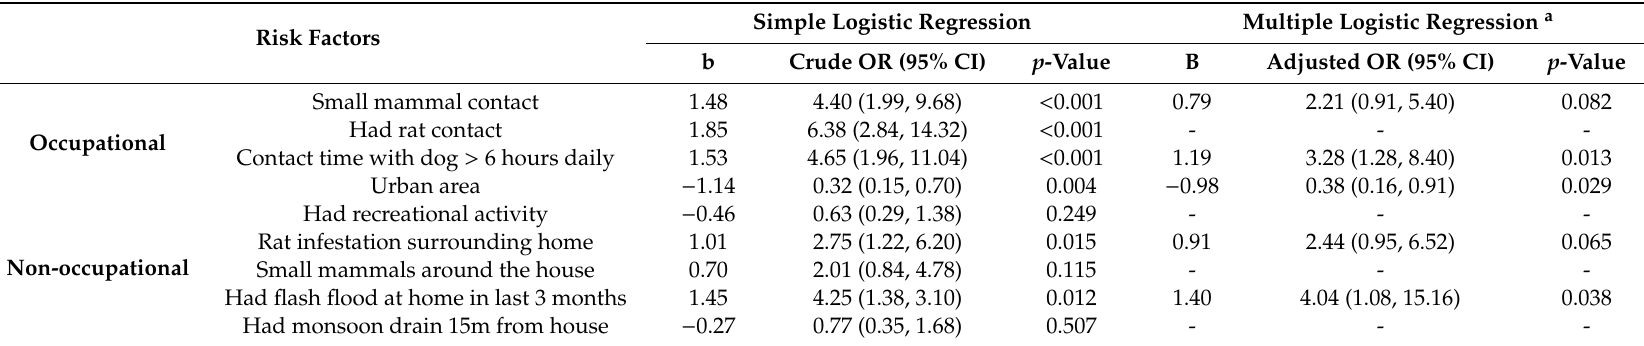
Table 3. Occupational and non-occupational risk factors a ff ecting dog handlers’ leptospiral seropositivity from working dog and shelter dog organisations. Risk